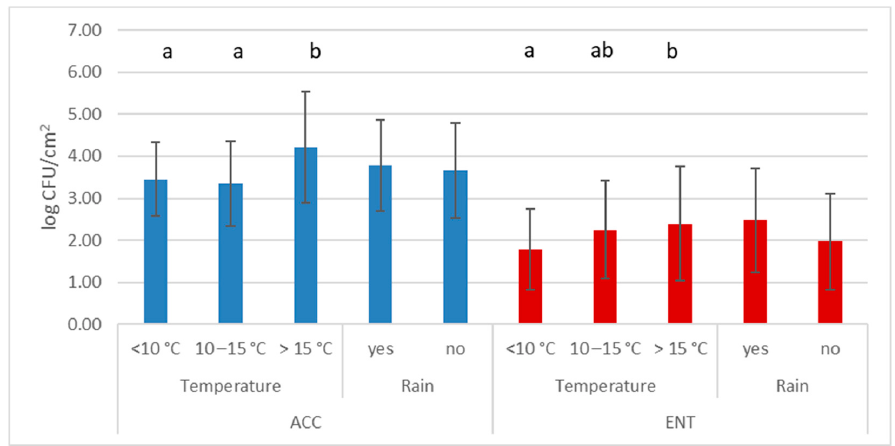
Figure 2. Mean values and standard deviation (bars) of aerobic colony count (ACC) and Enterobacteriaceae count (ENT) relative to environmental conditions during hunting; n = 120. Different superscript letters for factors indicate statistically different mean values ( p < 0.05).